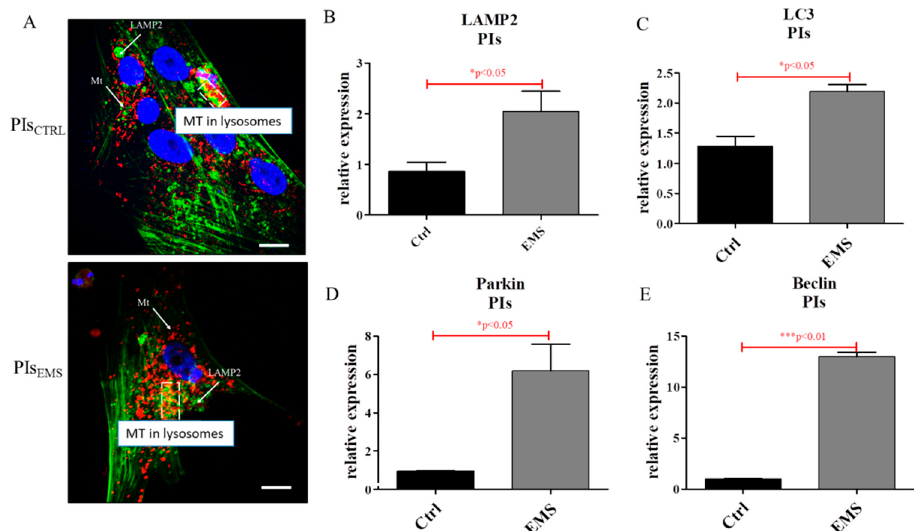
Figure 7. Autophagy in PIs. Using confocal microscopy, co-localization of LAMP2 and mitochondria was visualized in investigated cultures ( A ). Representative photographs indicate increased lysosome and mitolysosome formation in EMS groups. Moreover, using qRT-PCR, the expression of autophagy-related genes including LAMP2 ( B ), LC3 ( C ), Parkin ( D ) and Beclin ( E ) was evaluated. The obtained data confirmed increased autophagy in PIs EMS . Scale bars: confocal microscope: 5 µm. Results expressed as mean ± S.D. * p < 0.05, *** p < 0.001.